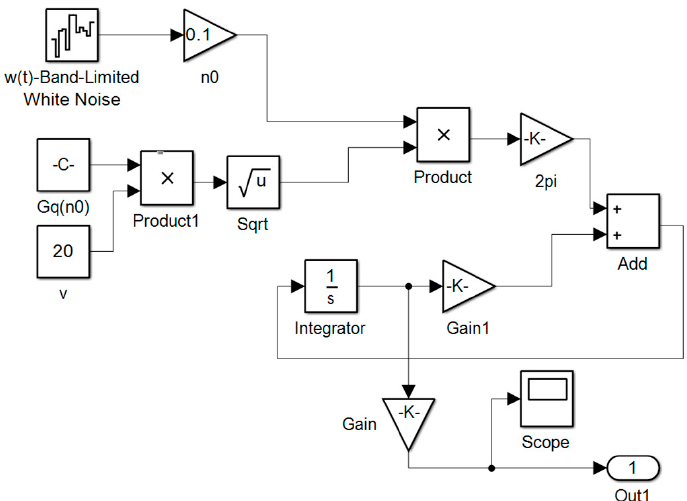
Figure 3. Simulation model of a random road. Table 1. The simulation parameters of the random road.